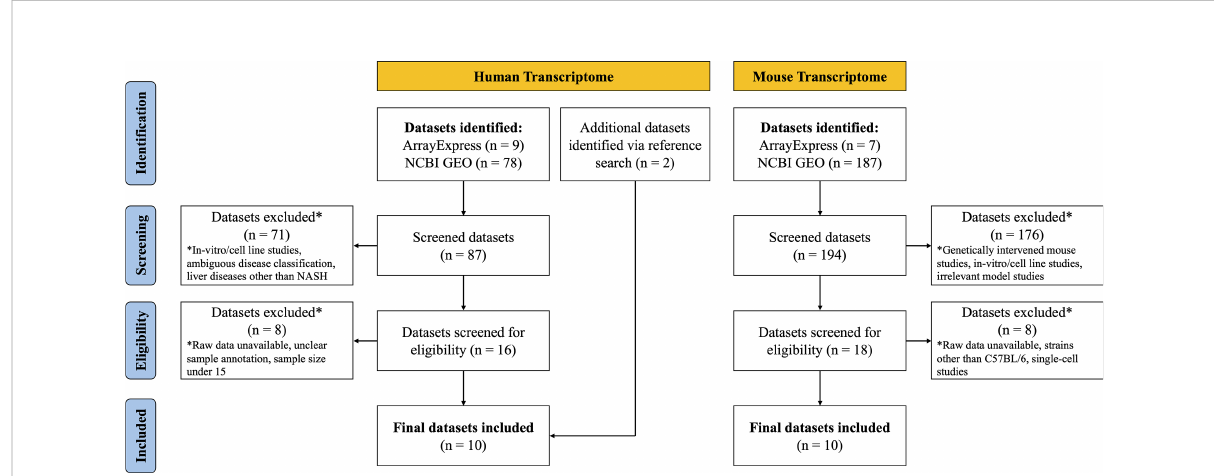
FIGURE 1 Flow diagram on the selection process of human and mouse NASH transcriptome